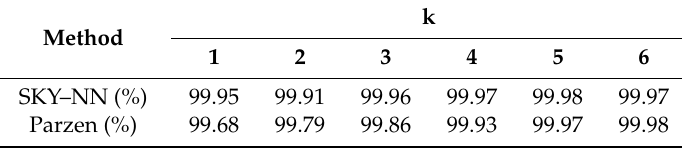
Figure 11. Dataset III. Table 18. Single skyline on the synthetic Dataset III.